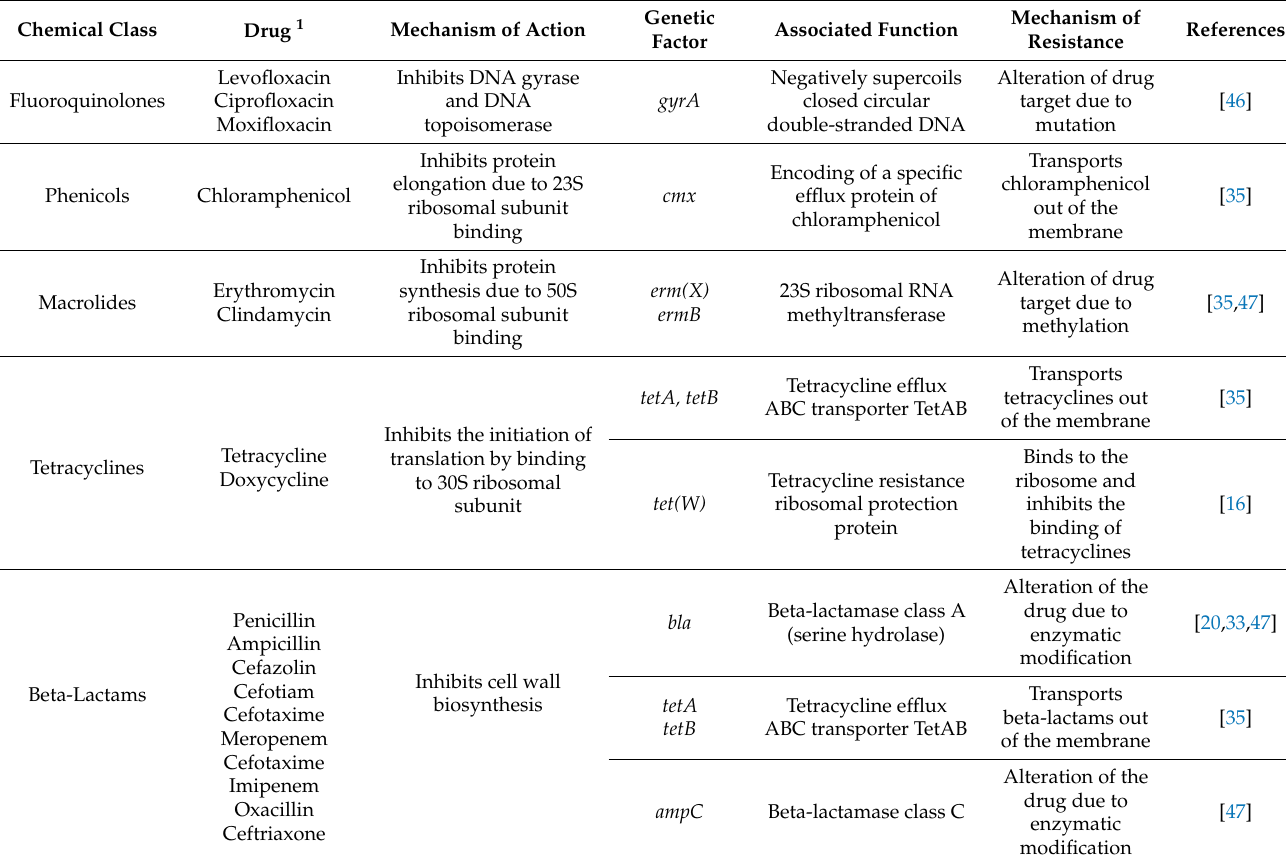
Table 2. Genetic factors involved in drug resistance in Corynebacterium striatum